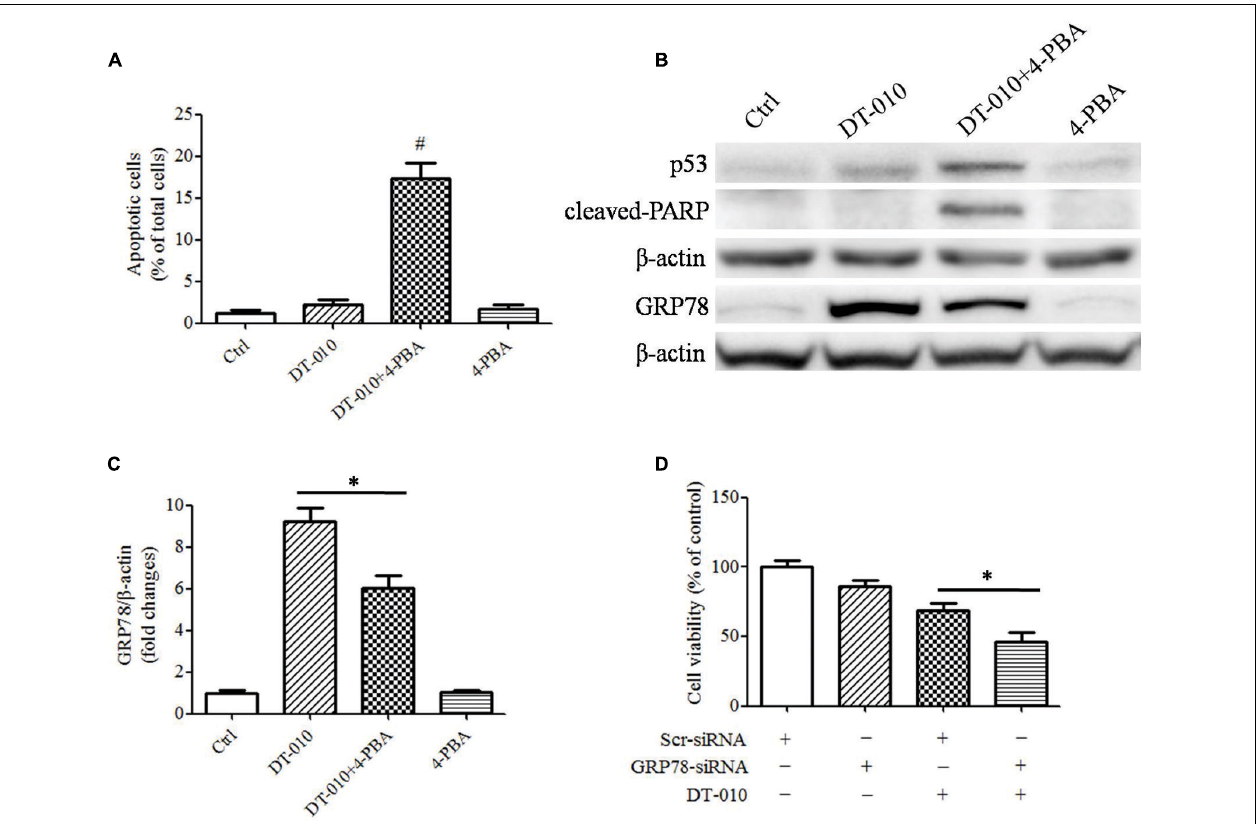
FIGURE 5 | Inhibition of GRP78 expression enhanced DT-010-induced cell apoptosis in MCF-7 cells. (A) The percentage of apoptotic cells in MCF-7 cells was recorded after 24 h of DT-010 treatment in the presence or absence of ER stress inhibitor 4-PBA. # P < 0.05 vs. DT-010 treated group. (B) MCF-7 cells were treated with Dox and DT-010 for 24 h, the expression of p53, cleaved-PARP, β -actin proteins were measured by western blot. The expression of GRP78 protein was determined after 12 h of Dox and DT-010 treatment. Representative immunoblots for the expression of p53, cleaved-PARP, β -actin and GRP78 proteins. (C) Densitometric quantification of the expression of GRP78 protein. (D) GRP78 knockdown further promotes DT-010-induced cell death in MCF-7 cells. ∗ means significant difference between treatments ( P <